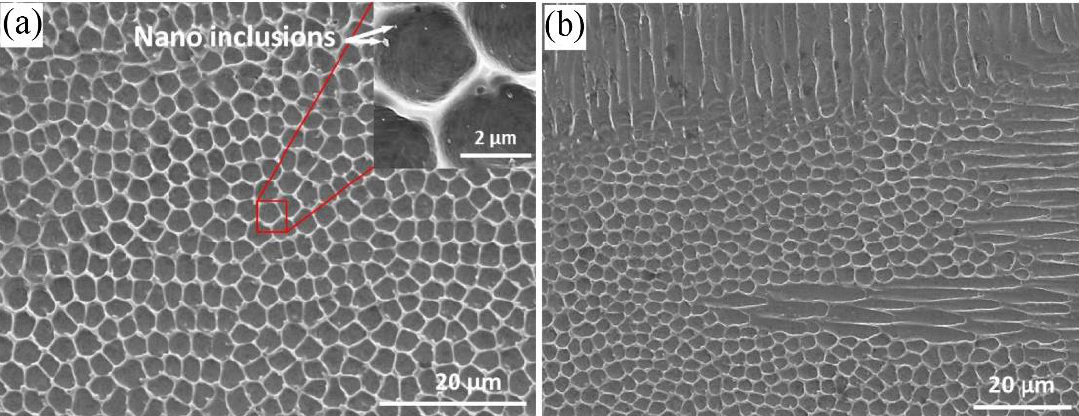
Figure 11. SEM images illustrating the typical cellular microstructure of powder-feed direct laser deposited AISI 316L steel: ( a ) equiaxed cells; and ( b ) evidence of elongated cells at the melt pool boundaries. Reprinted with permission from [19], Copyright 2020 Elsevier.